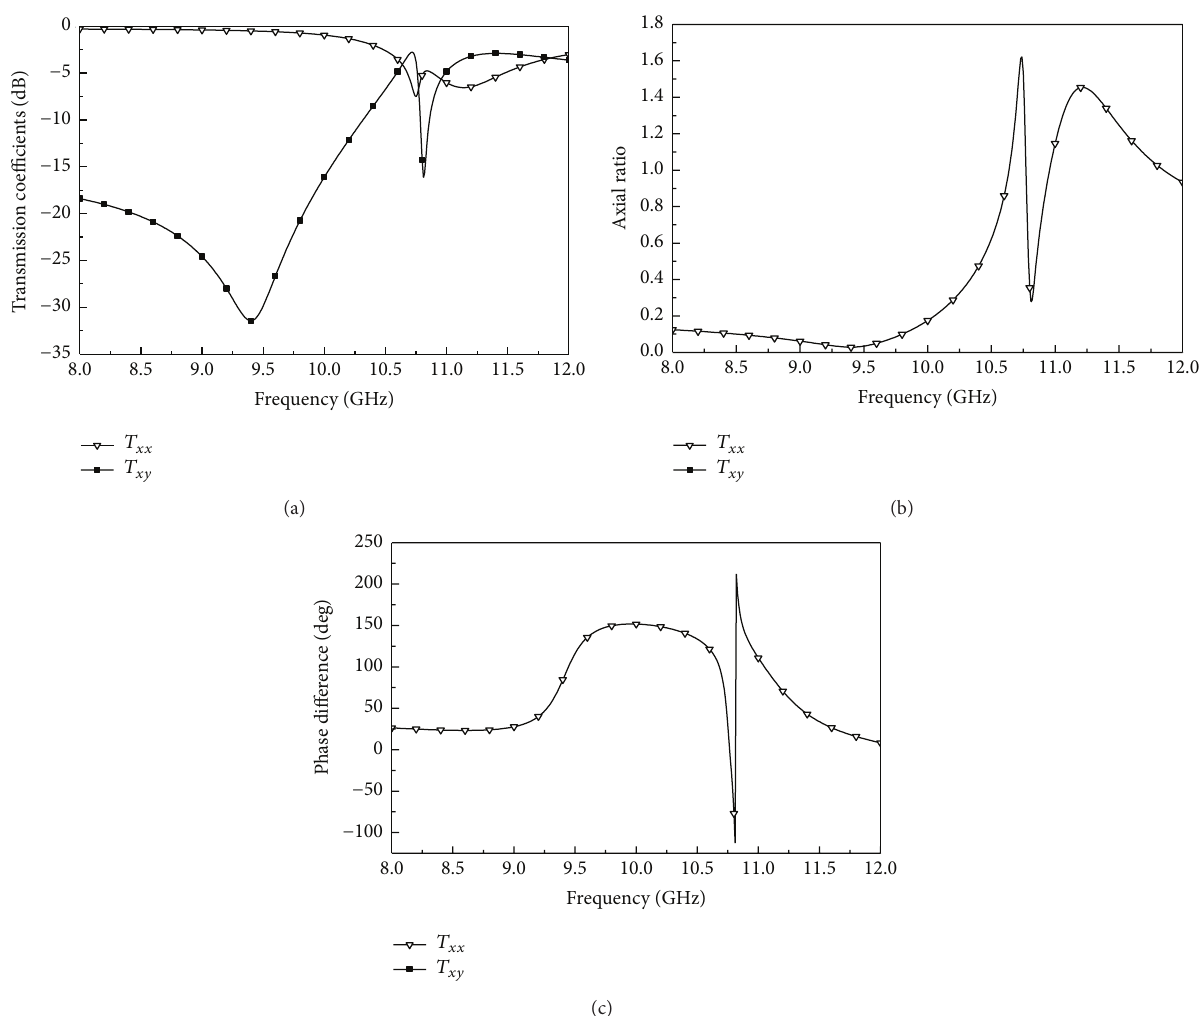
Figure 2: The figure presents the simulation results for dual-band circular polarizer. (a) shows the transmission coefficients of 𝑇 𝑥𝑥 and 𝑇 𝑥𝑦 versus frequency for normal incident wave at 𝜃 = 0 ∘ , (b) represents the axial ratio of transmitted wave versus frequency, and (c) shows the phase difference between transmitted waves versus frequency of designed